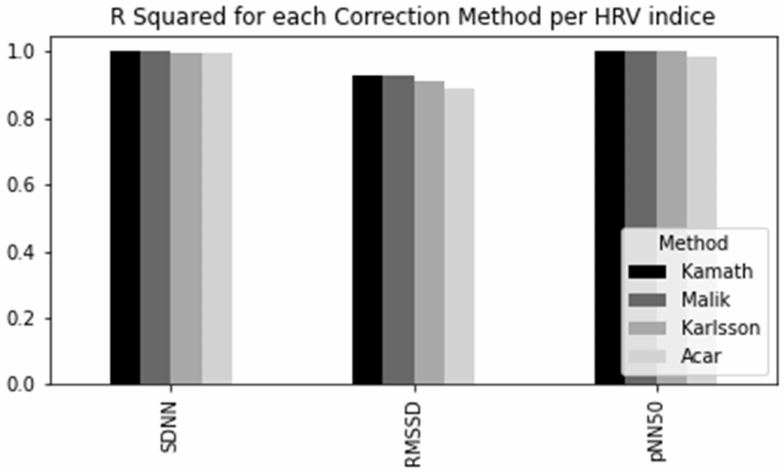
Figure 14. Comparison of the correction